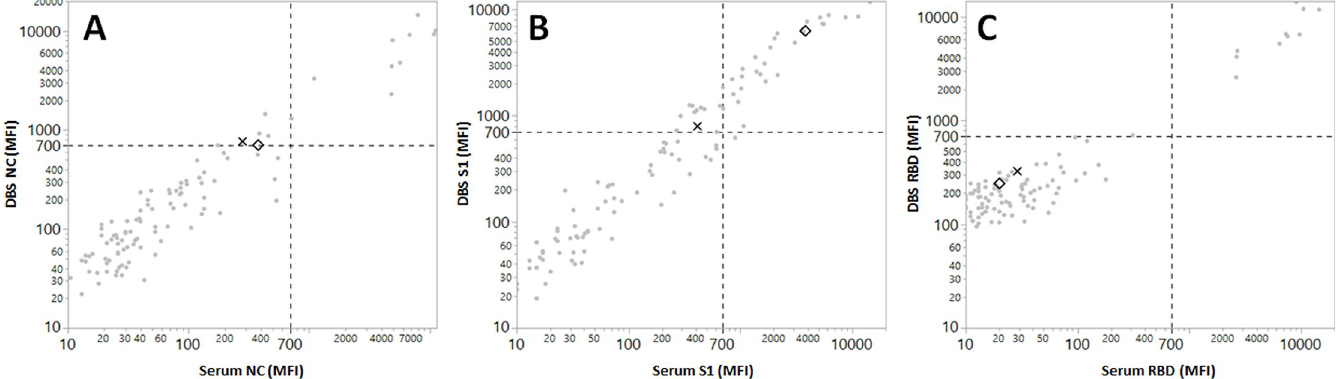
Fig 1. Result comparison of 107 paired DBS and serum samples analyzed for IgG against the SARS-CoV-2 nucleocapsid (NC, panel A), spike glycoprotein S1 subunit (S1, panel B) and receptor binding domain (RBD) antigens (panel C) using the Luminex xMAP assay. The samples represented by the X and the diamond indicate two cases with discordant result interpretations.